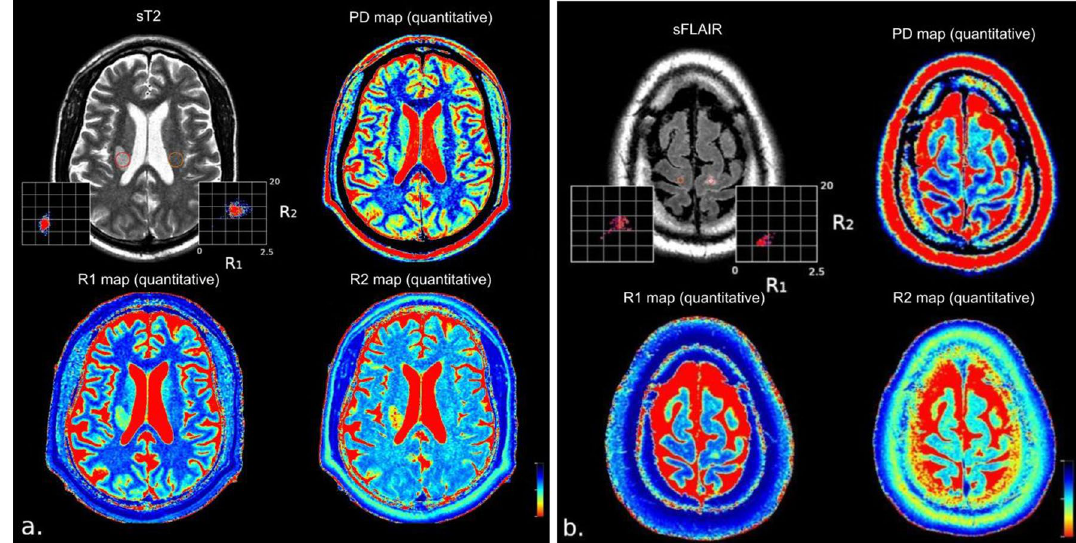
Figure 2. Representative examples of ROI in lesions ( a acute ischemic lesion DWI + /rADC, b chronic ischemic lesion WMH) and contralateral mirror NBR in a sT2 weighted image (upper left quadrant) with R 1 R 2 Plot (scales: 0–2.5 [1/s]; 0–20 [1/s]) and R1 (lower left quadrant, red-to-blue colorbar scale: 0–2000 [ms]), PD (upper right quadrant, red-to-blue colorbar scale: 0–100 [pu]) and R2 (lower right quadrant, red-to-blue colorbar scale: 0–200 [ms]) quantitative